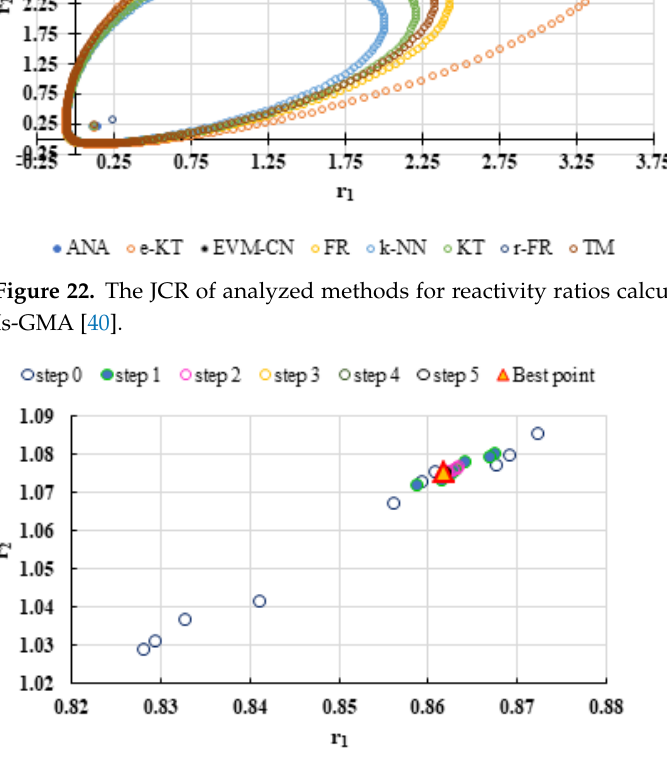
Figure 23. Distribution of P cen (r 1 , r 2 ) points for each step of searching for the k-NN method for copolymerization of NIPAM-NVP [41]. Table 23. The reactivity ratios obtained for copolymerization of NIPAM-NVP [41].